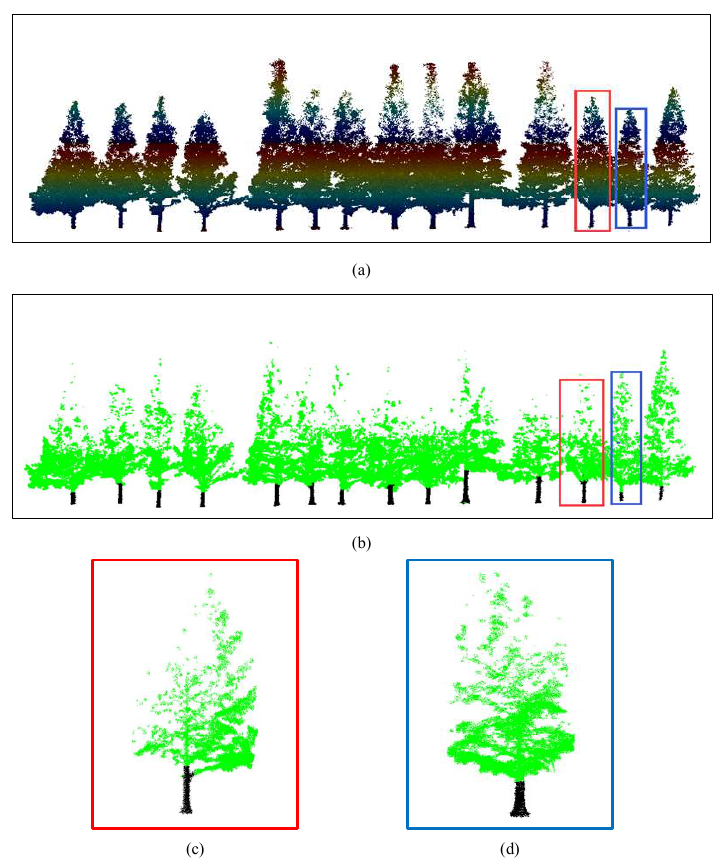
Figure 16. Processing result for dataset 5: ( a ) individual tree segmentation; ( b ) trunk extraction; ( c ) over-extraction of trunk; ( d ) incomplete extraction of trunk.